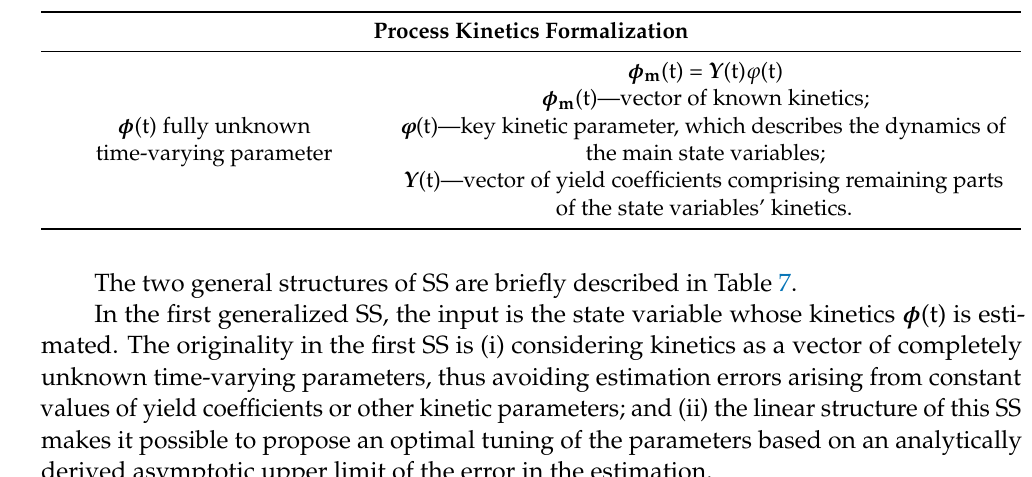
Table 6. New formalizations of kinetics φ